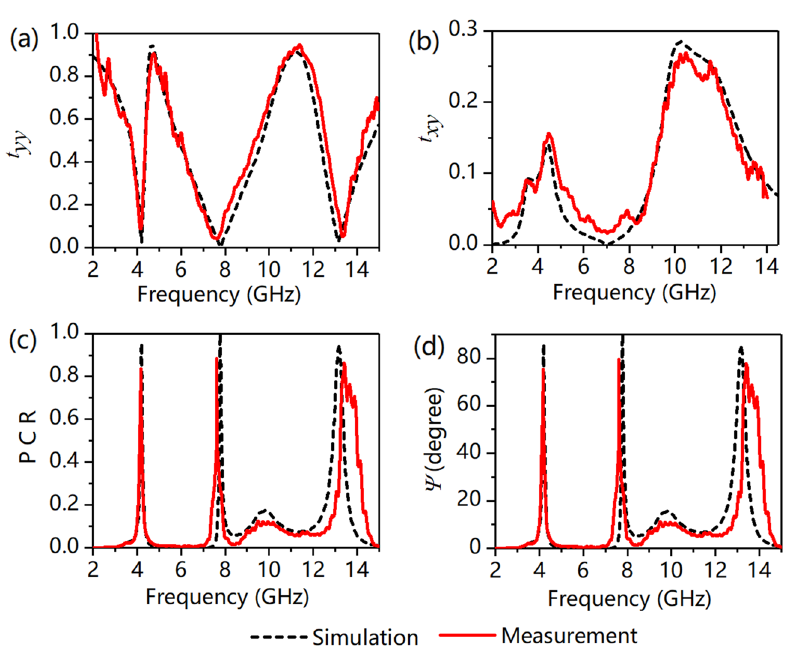
Figure 6. ( a ) Copolarization transmittance of t yy , ( b ) cross-polarization transmittance of t xy , ( c ) polarization conversion ratio (PCR), and ( d ) polarization rotation angle of Ψ